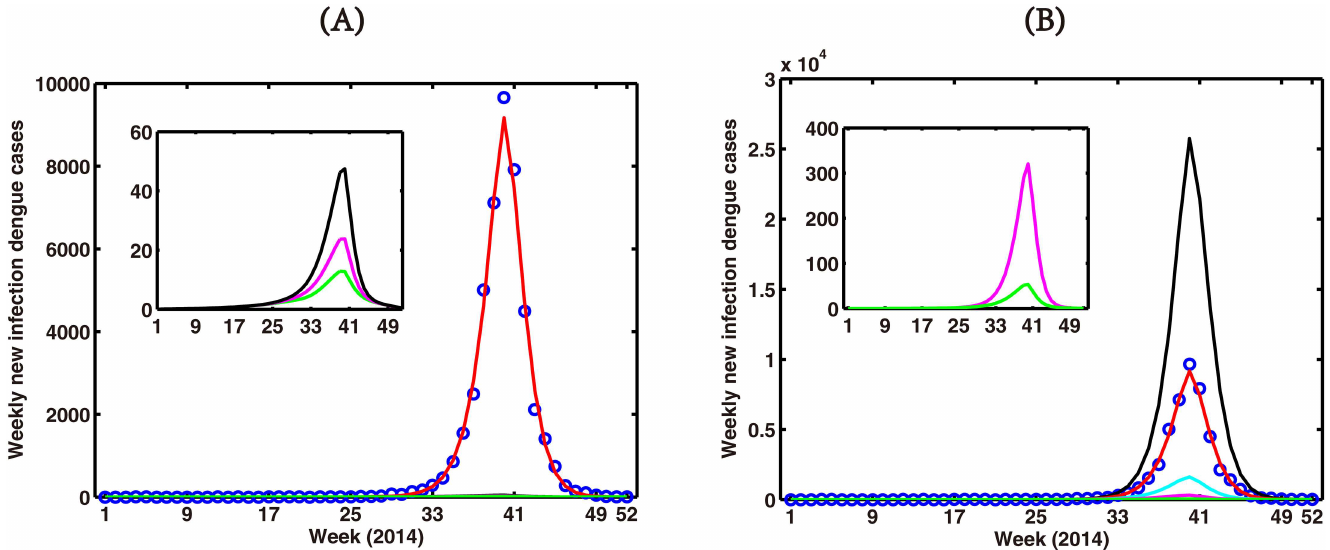
Fig 11. Trajectories of weekly new cases under different scenarios. Blue circles indicate the numberof weekly reportedinfectioncases. (A) Changing η . Red line denotes η = 100%. Black, purple and green lines are 20%, 10% and 0, respectively. (B) Changing κ E . The black line describes κ E = 3.0 × 10 6 . And red, cyan, purpleand green lines are 2.6042 × 10 6 , 2.0 × 10 6 , 1.5 × 10 6 , and 1.0 × 10 6 , respectively.